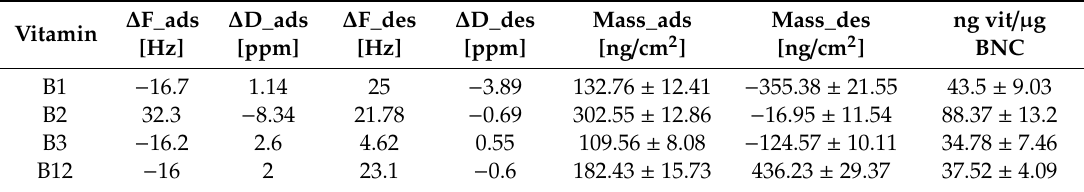
Table 1. Quantifications of changes in frequency ( Δ F), changes in dissipation ( Δ D) and mass calculated (Mass); Adsorption = ads; Desorption = des. Vitamin